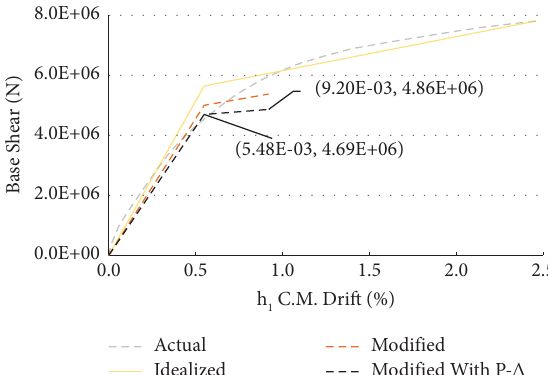
Figure 12: Modifed base shear-displacement curve of the reference point adapted for P − ∆